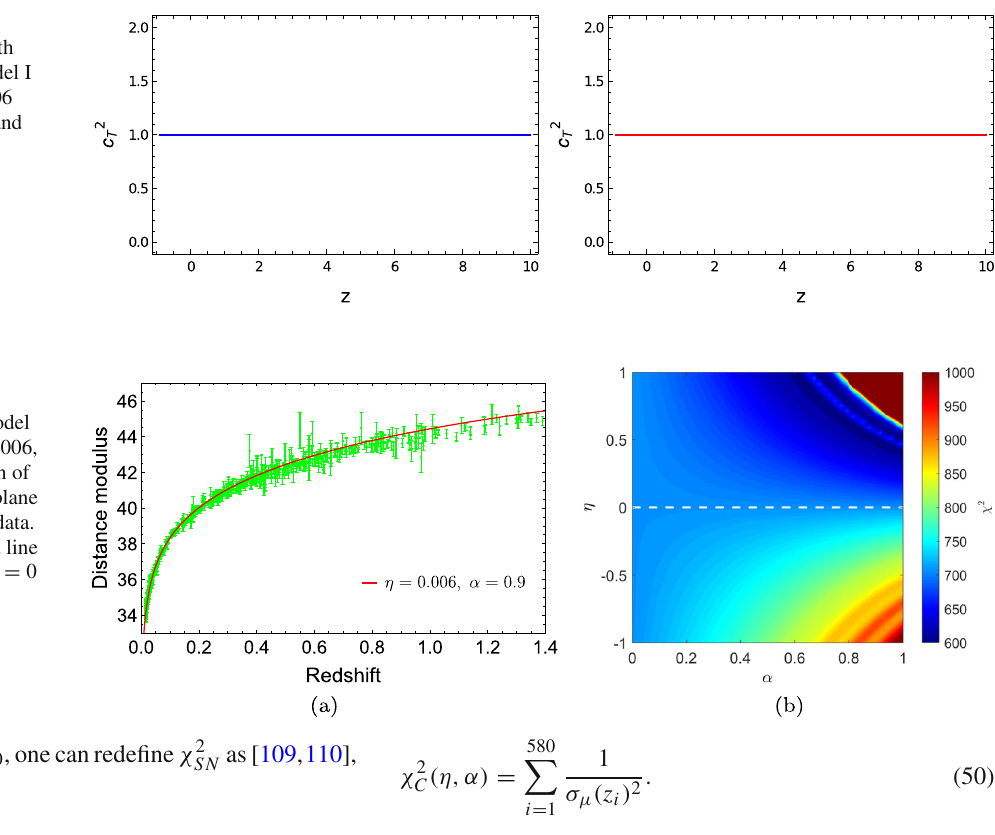
However, to get rid of μ 0 , one can redefine χ 2